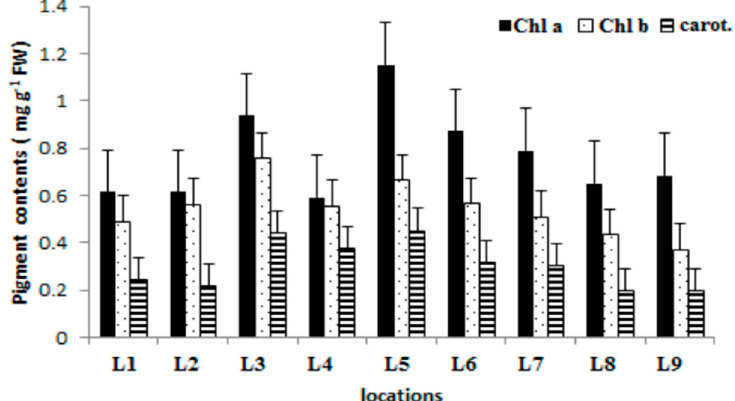
Figure 6. Content of chlorophyll (chl a, chl b) and carotenoid (carot.) in Trapa natans L. sampled from different locations.